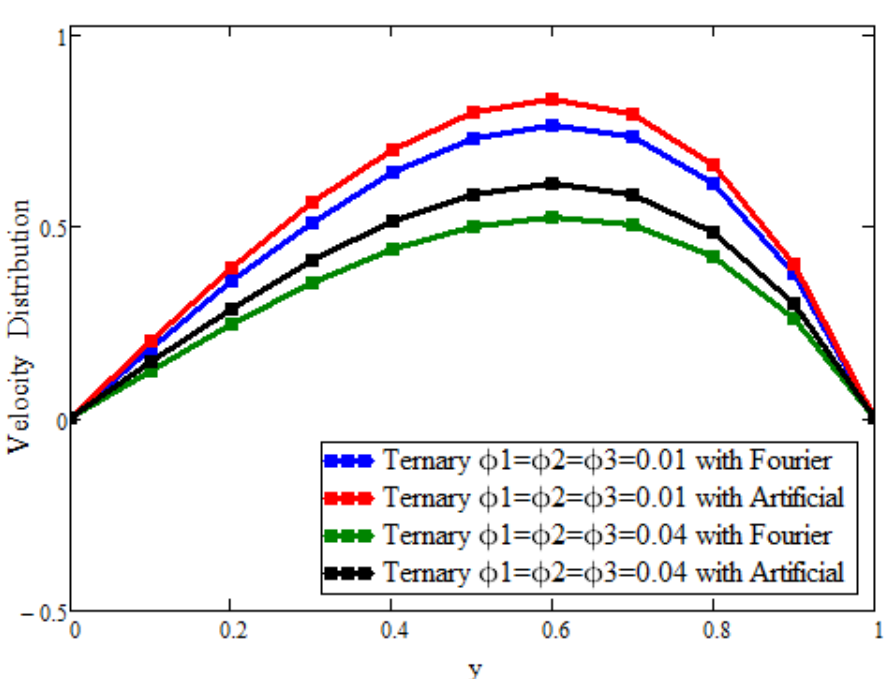
Figure 7. The effect of the volumetric fraction on the velocity field. Here, Pr = 21, a = 0.02, t = 2, α = 0.7, β = 0.7, γ = 0.7, Gr = 15, and M =